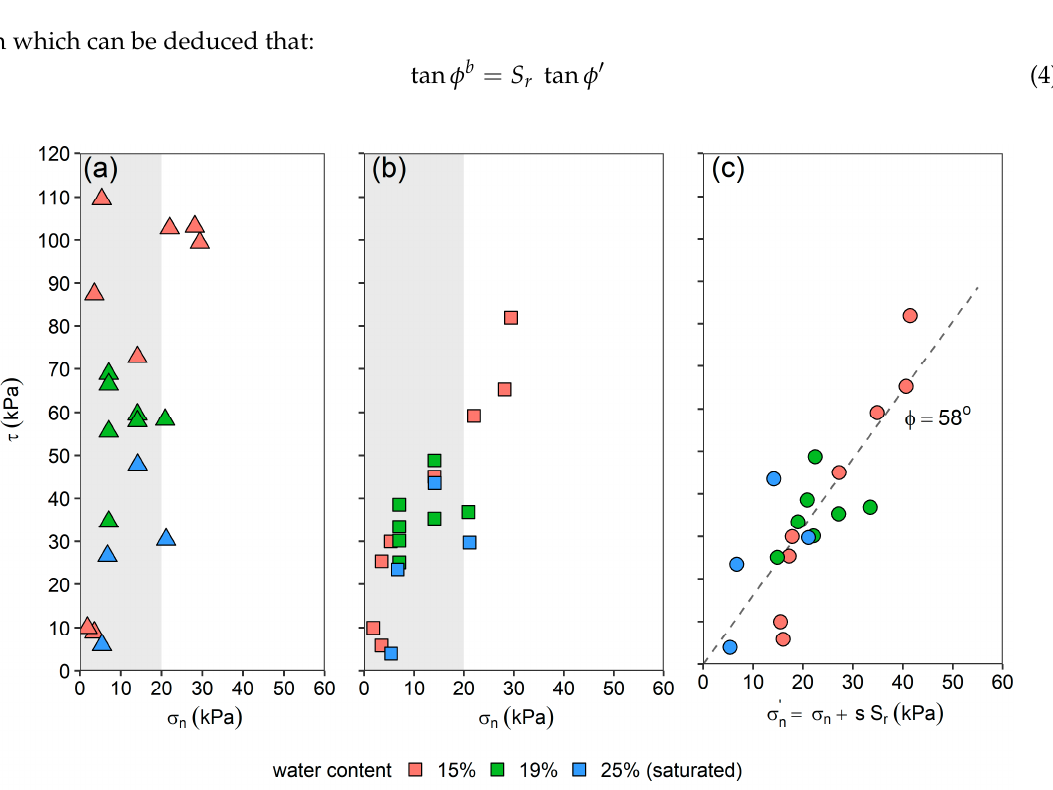
Figure 7. Results of direct shear tests performed on partially and completely saturated samples. ( a ) Normal stress versus peak shear stress; ( b ) normal stress versus constant volume shear stress; ( c ) Bishop’s generalized effective normal stress versus constant volume shear stress. Shaded grey area represents the range of normal stresses expected on the monitored soil layer.